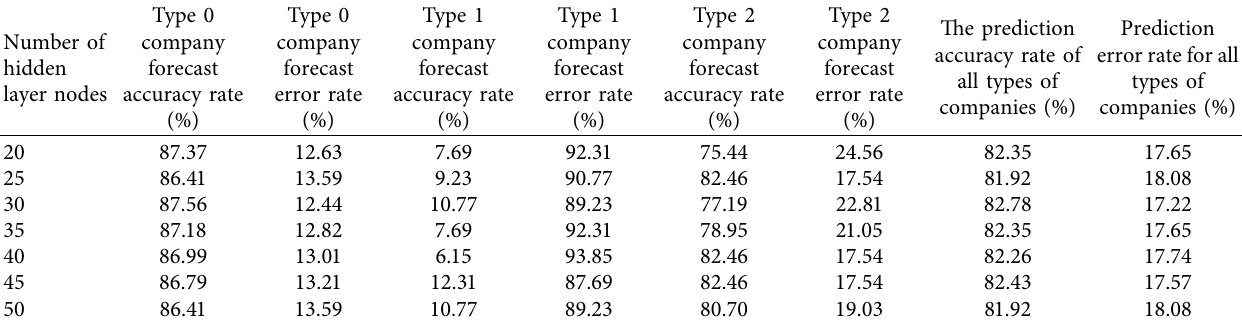
Table 6: BP Network predicts the financial risk status of listed companies in 2010 (in percentage